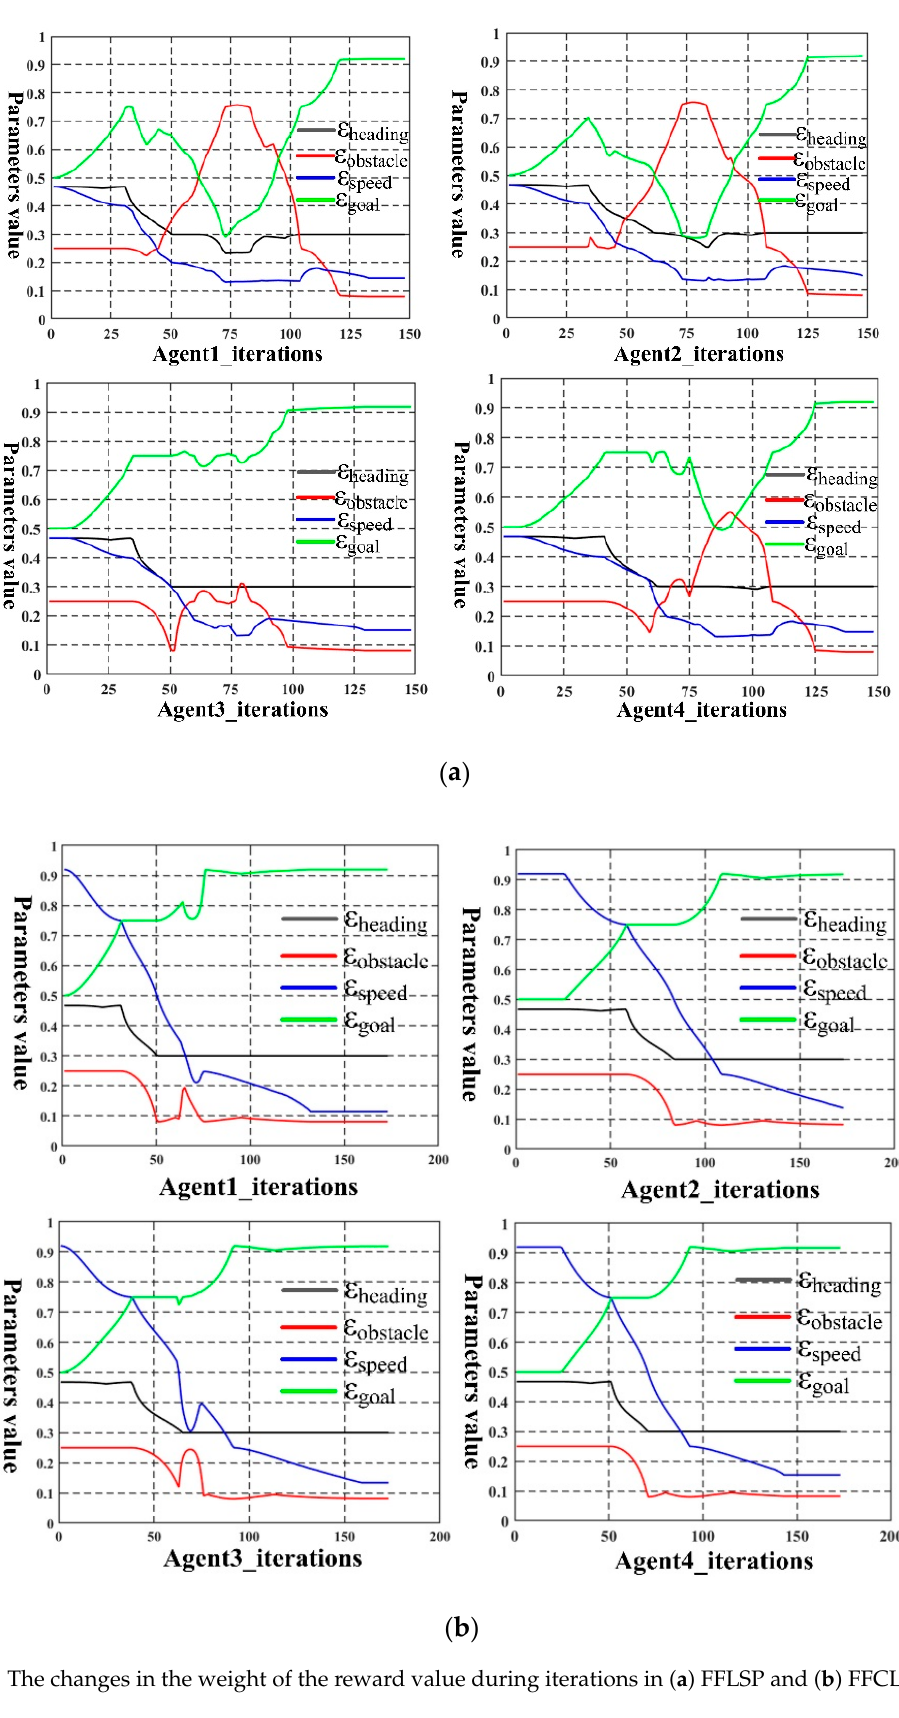
Figure 15. The changes in the weight of the reward value during iterations in ( a ) FFLSP and ( b ) FFCL